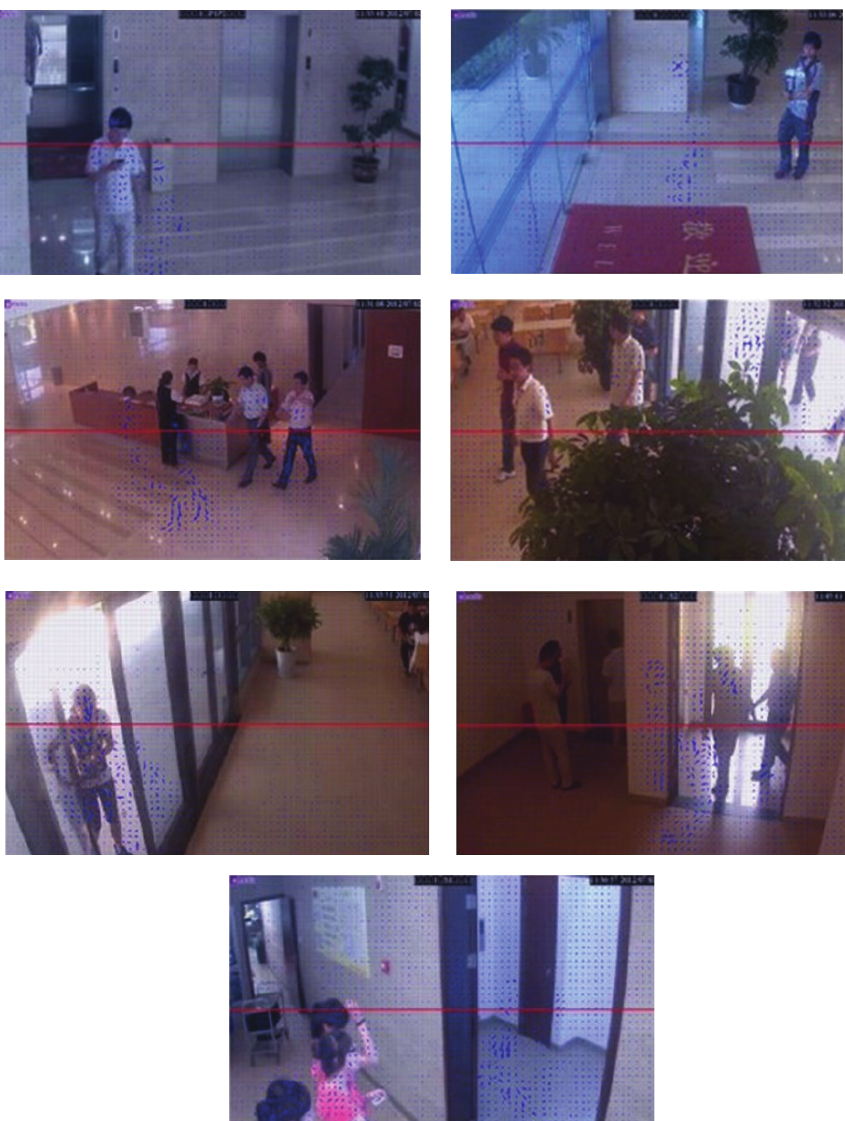
Figure 9: The experiment result of optical